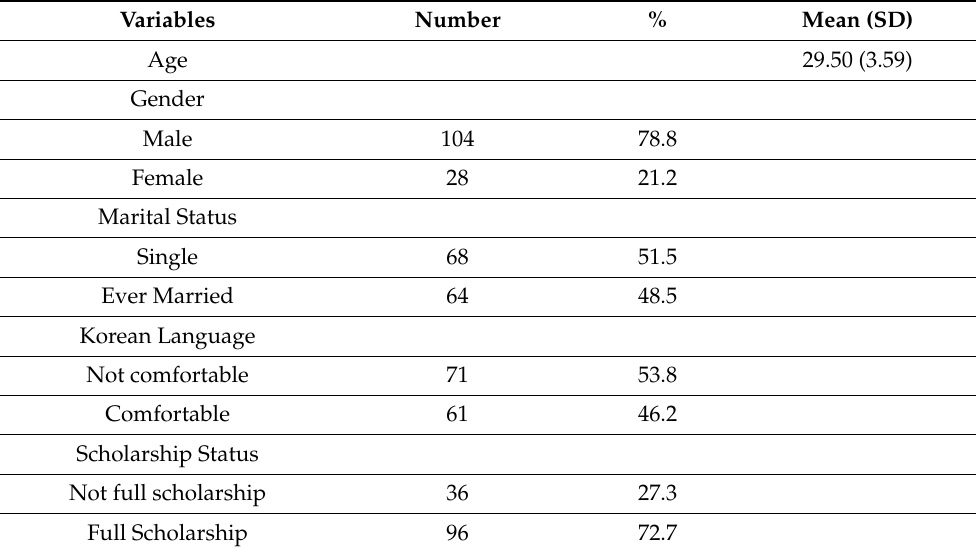
Table 1. Demographic information of the sample (sample = 132).